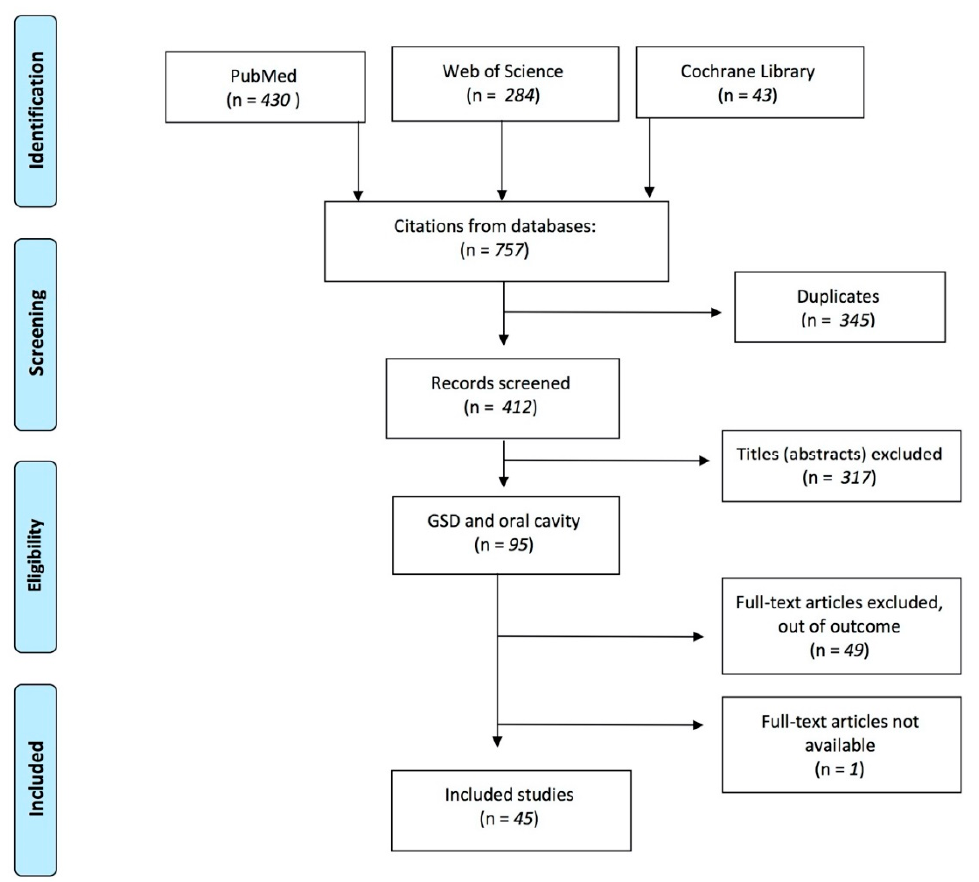
Figure 1. The PRISMA flow diagram summarizes the steps in the selection